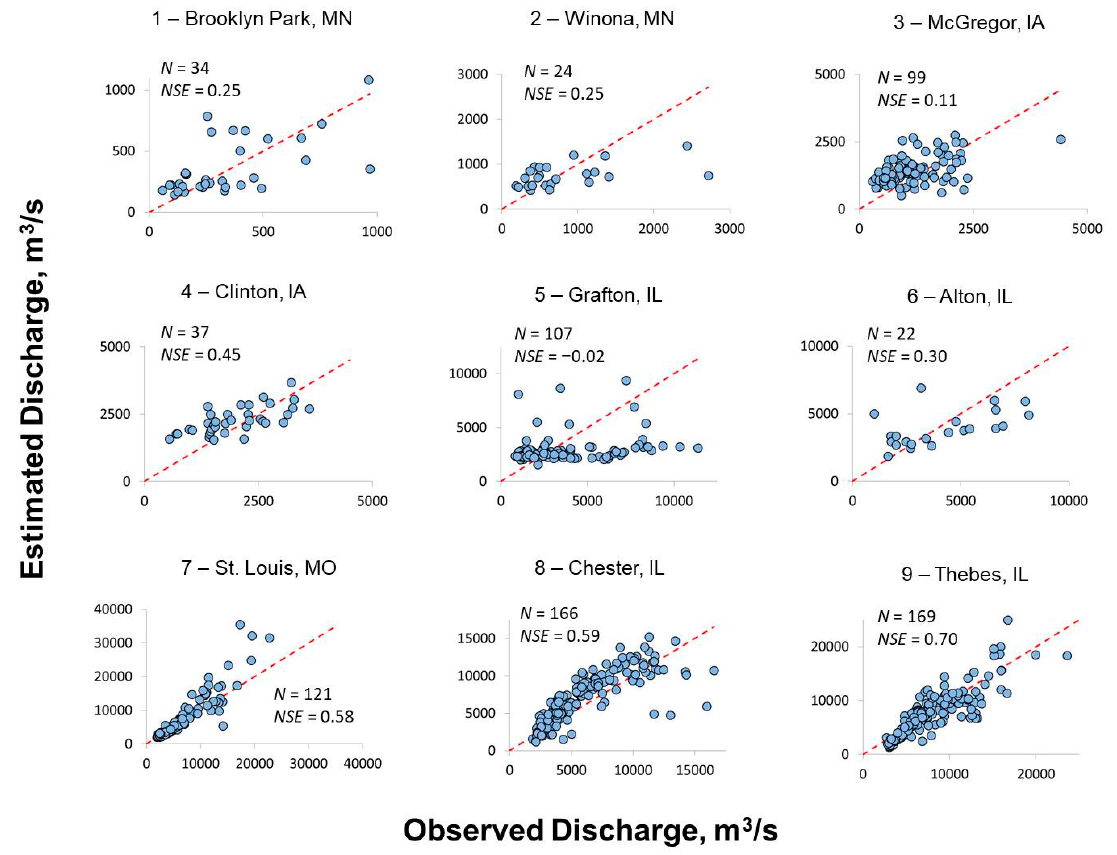
Figure 8. Estimated and observed river discharges (1984–2017) for the nine study sites in the Upper Mississippi River. The dashed line represents the 1:1 relationship.